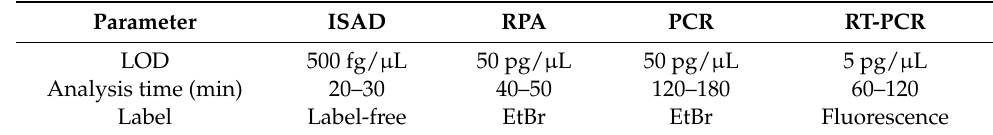
Table 4. Comparison of LOD, analysis time, and label of various methods [131].